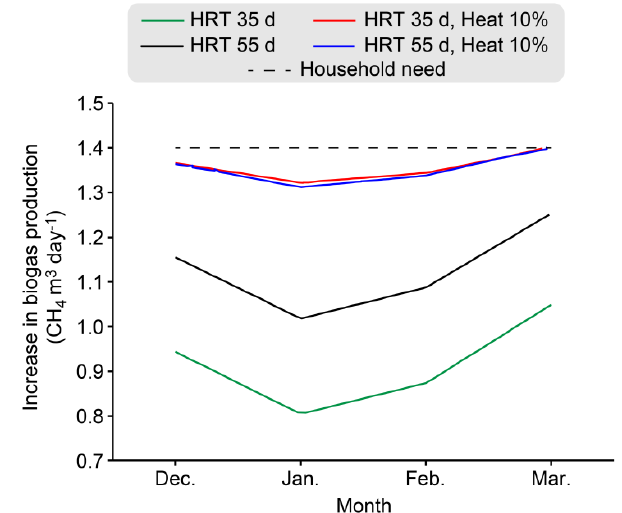
Figure 6. Daily biogas production in winter from the manure of 16 animals, with 10% of the digester heat provided by biogas at a dilution ratio of 1:3.